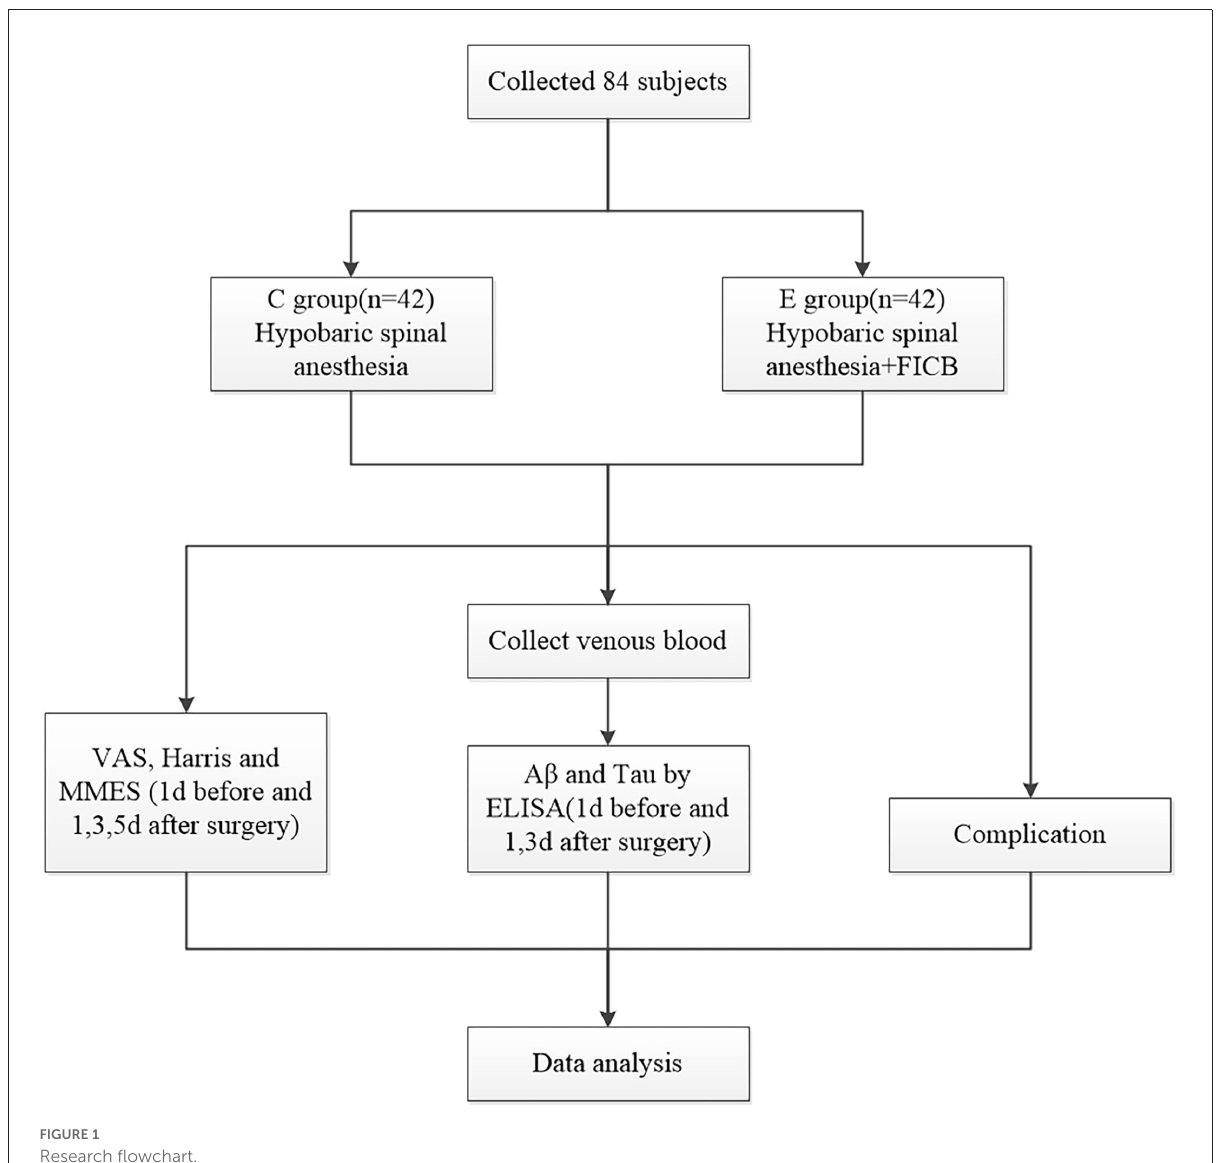
FIGURE1 Research flowchart.